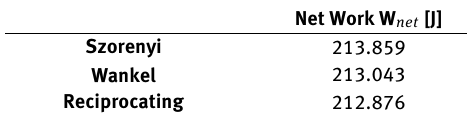
Table 2: Net work comparison between